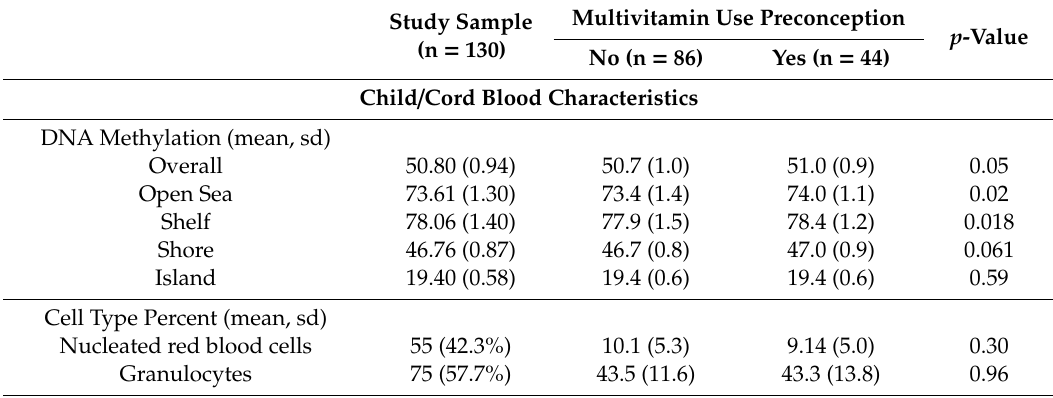
Table 1. Multivitamin use preconception by covariates in the Early Autism Risk Longitudinal Investigation (EARLI). p -values for di ff erence in variables by multivitamin intake is from t-test for continuous variables, and chi-square test for categorical variables. Acronyms: Standard deviation